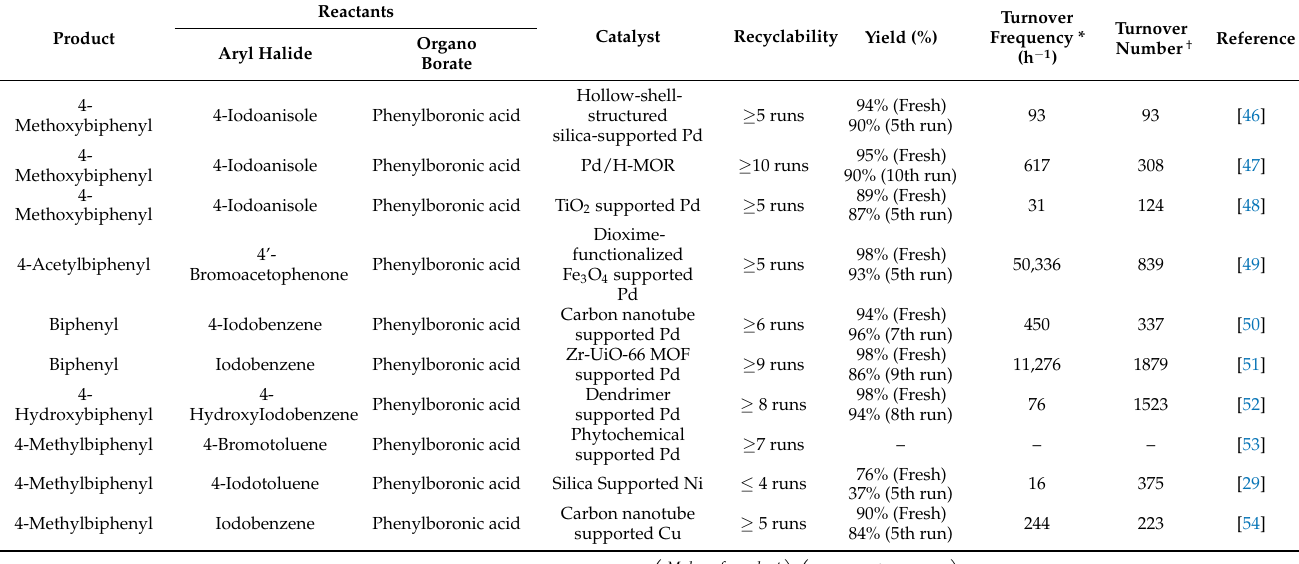
Table 1. Supporting materials and their